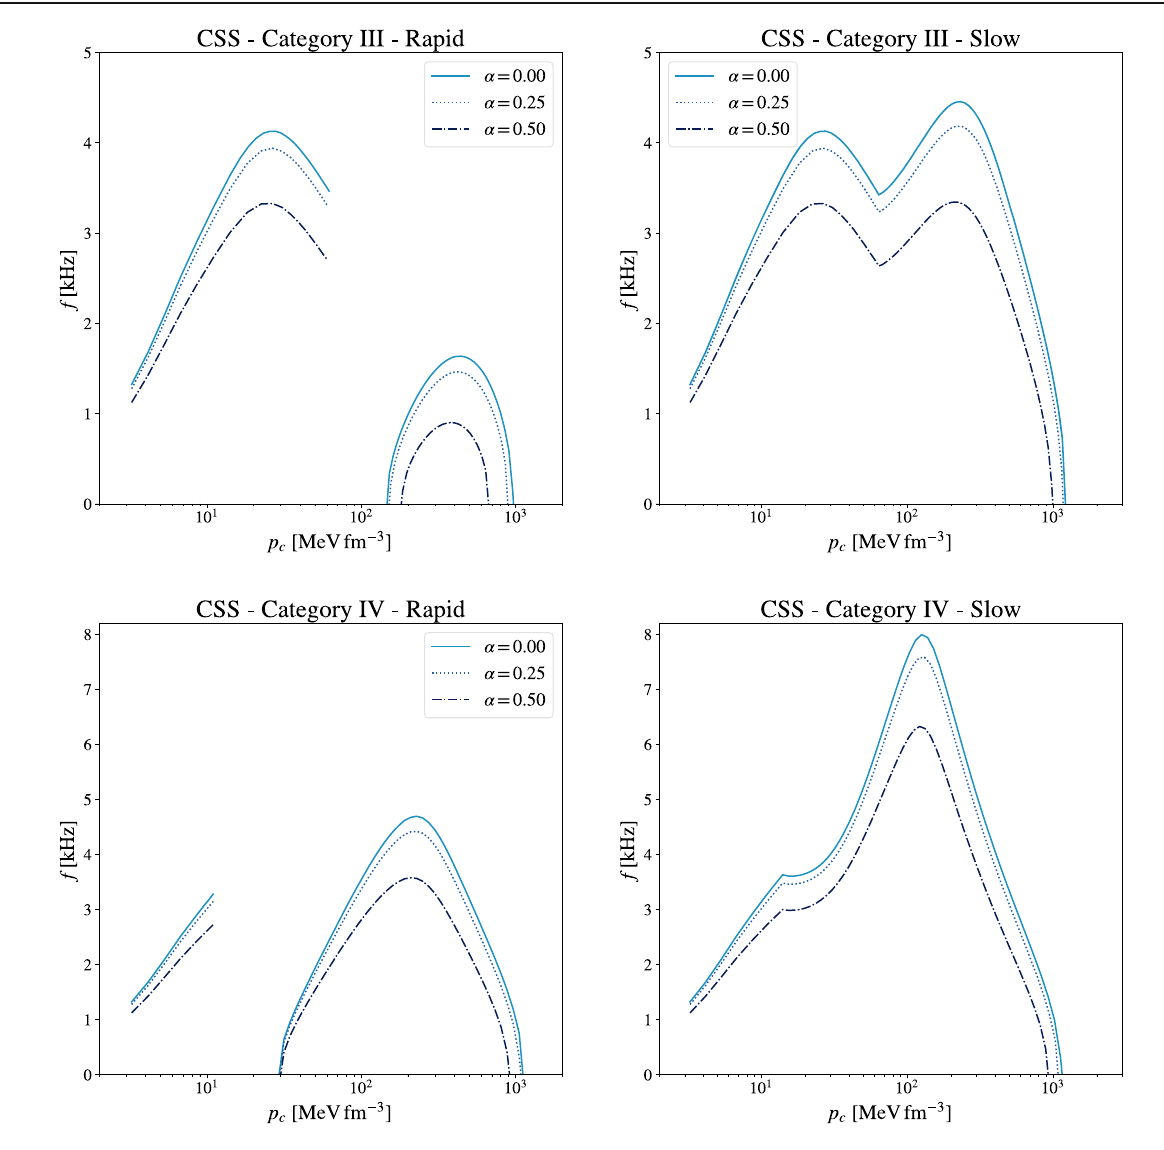
Fig. 3 Predictionsforthefundamentallineareigenfrequencyasafunc- tion of central pressure for charged twin stars considering rapid (left panel) and slow (right panels) conversions and the Categories III (upper